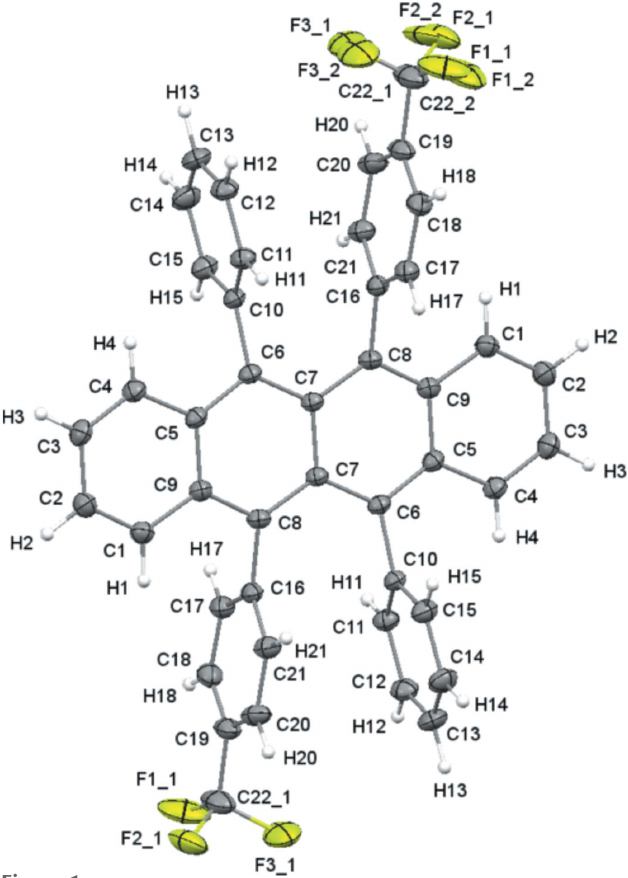
Figure 1 Crystal structure of 1 with displacement ellipsoids shown at the 50% probability level.